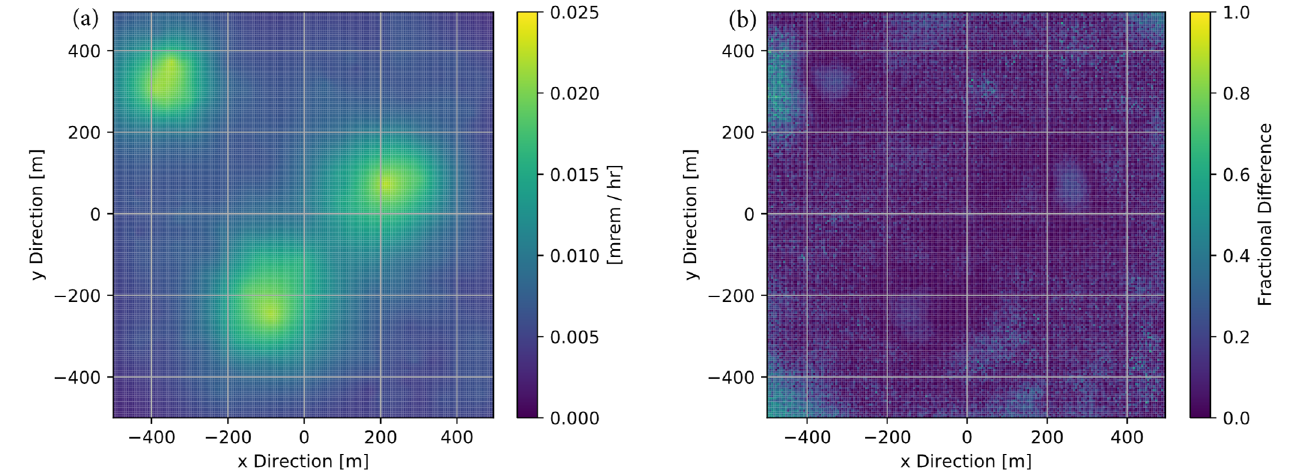
Figure 3. Five-sensor survey results showing ( a ) the predicted distribution for E = 0.90 and ( b ) the grid-by-grid fractional difference to the true distribution shown in Figure 1.